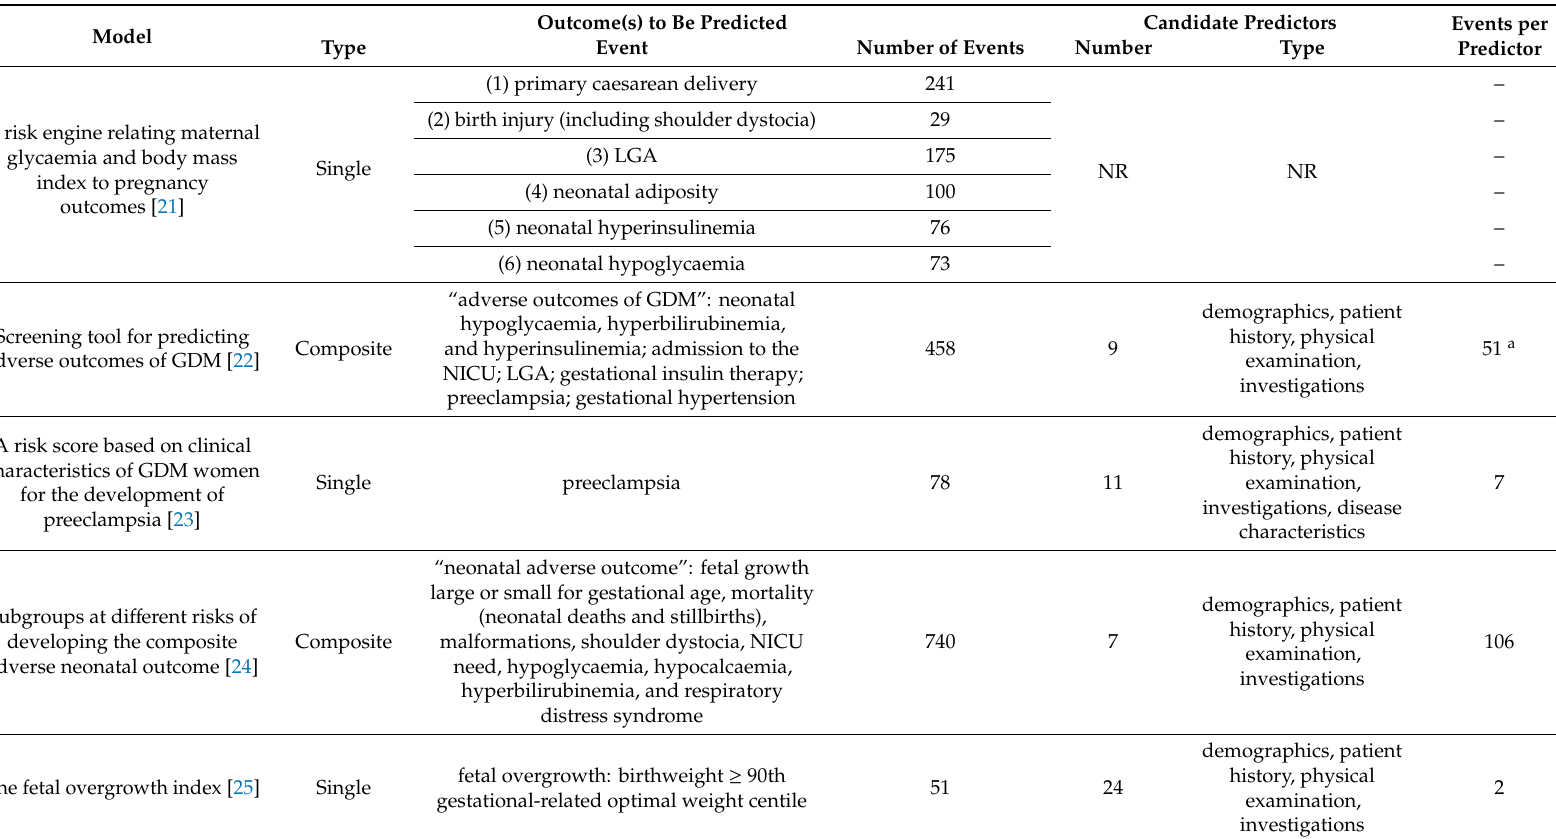
Table 4. Outcome(s) to be predicted and candidate predictors in models for pregnancy complications in women with gestational